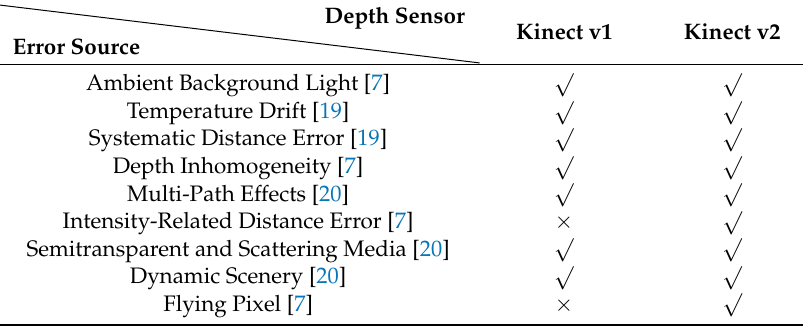
Table 3. Error sources for depth sensor of the Kinect v1 and Kinect v2 ( √ represents yes, and × represents no).